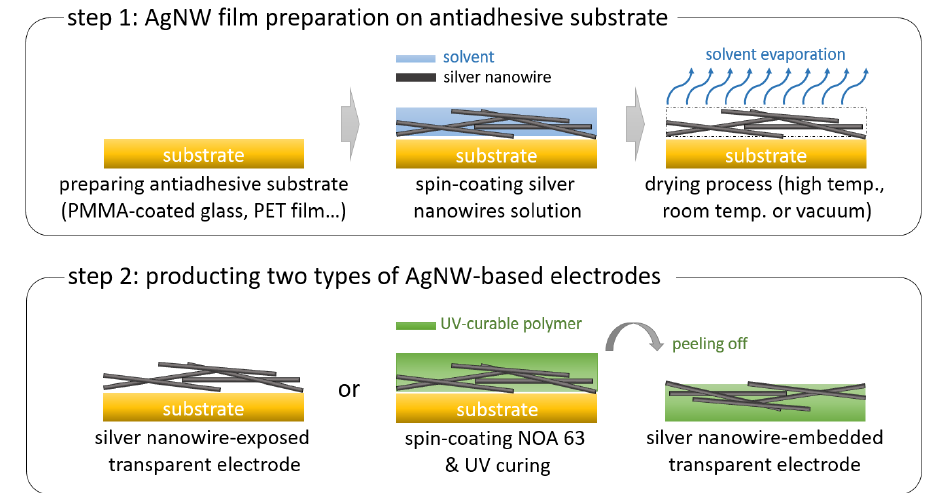
Figure 1. Scheme of the fabrication process of two types of silver nanowire (AgNW)-based transparent electrodes.